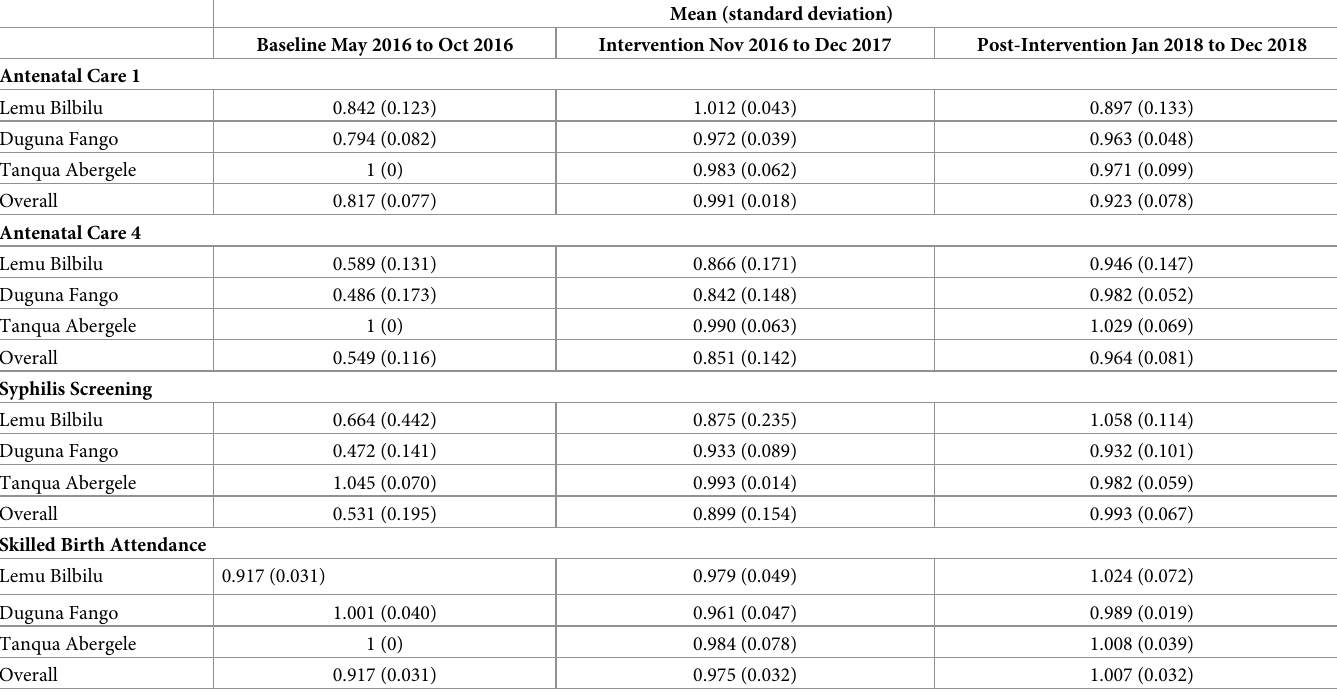
Table 2. Verification factor by woreda for the baseline, intervention and post-intervention